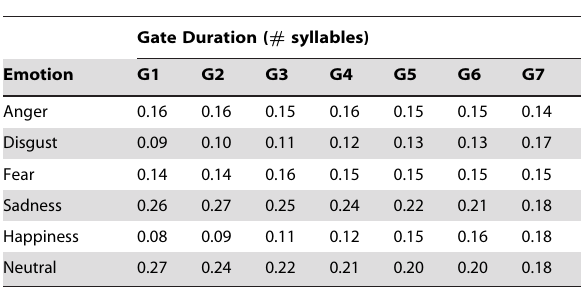
Table 3. Mean proportion of emotional response category usage at each gate duration interval for the 48 listeners (includes both correct and incorrect target